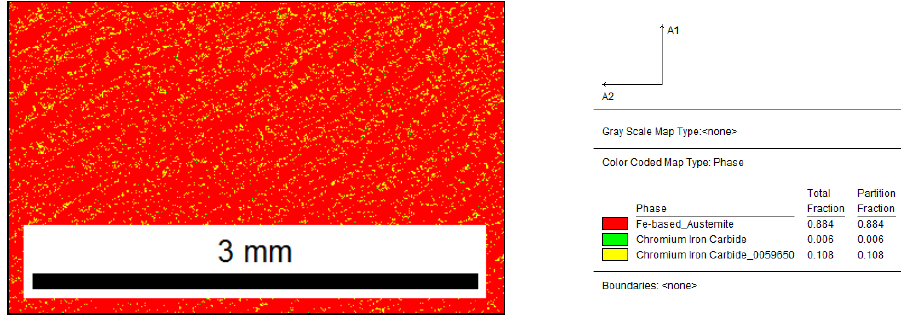
Figure 10. Inoculated sample with 0.66% Fe – Ti: distribution map of occurring phases.